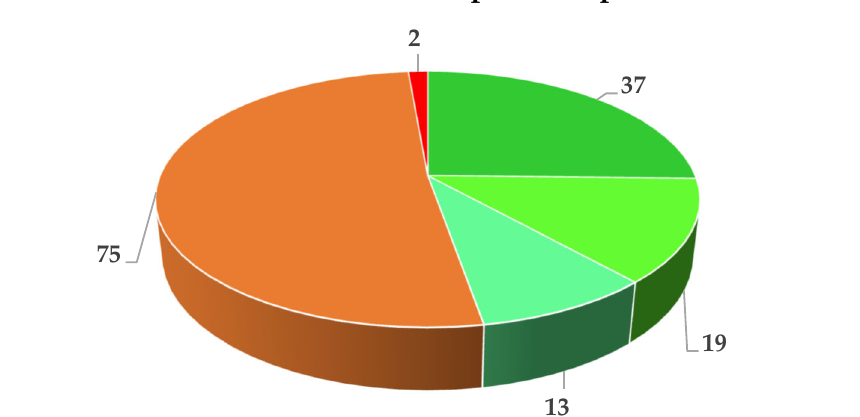
Figure 2. Frequency of reported oral HPV-related lesions in pediatric patients.